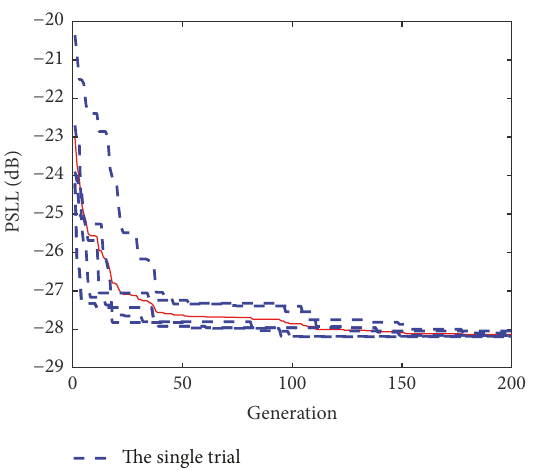
The single trial 5 trials averaged Figure 11: The convergence